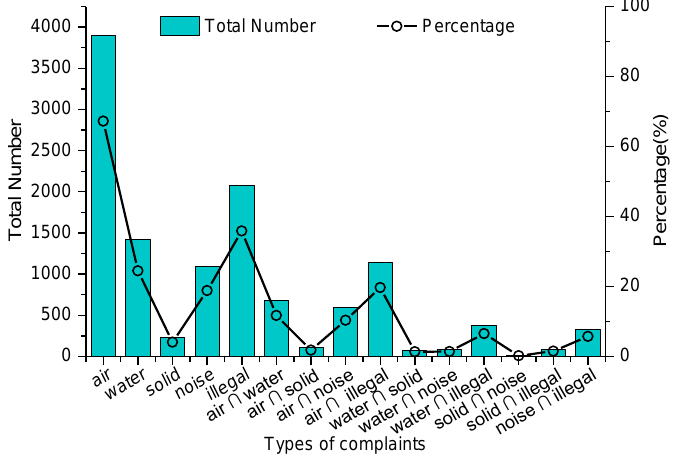
Figure 1. Quantity of different types of environmental problems.